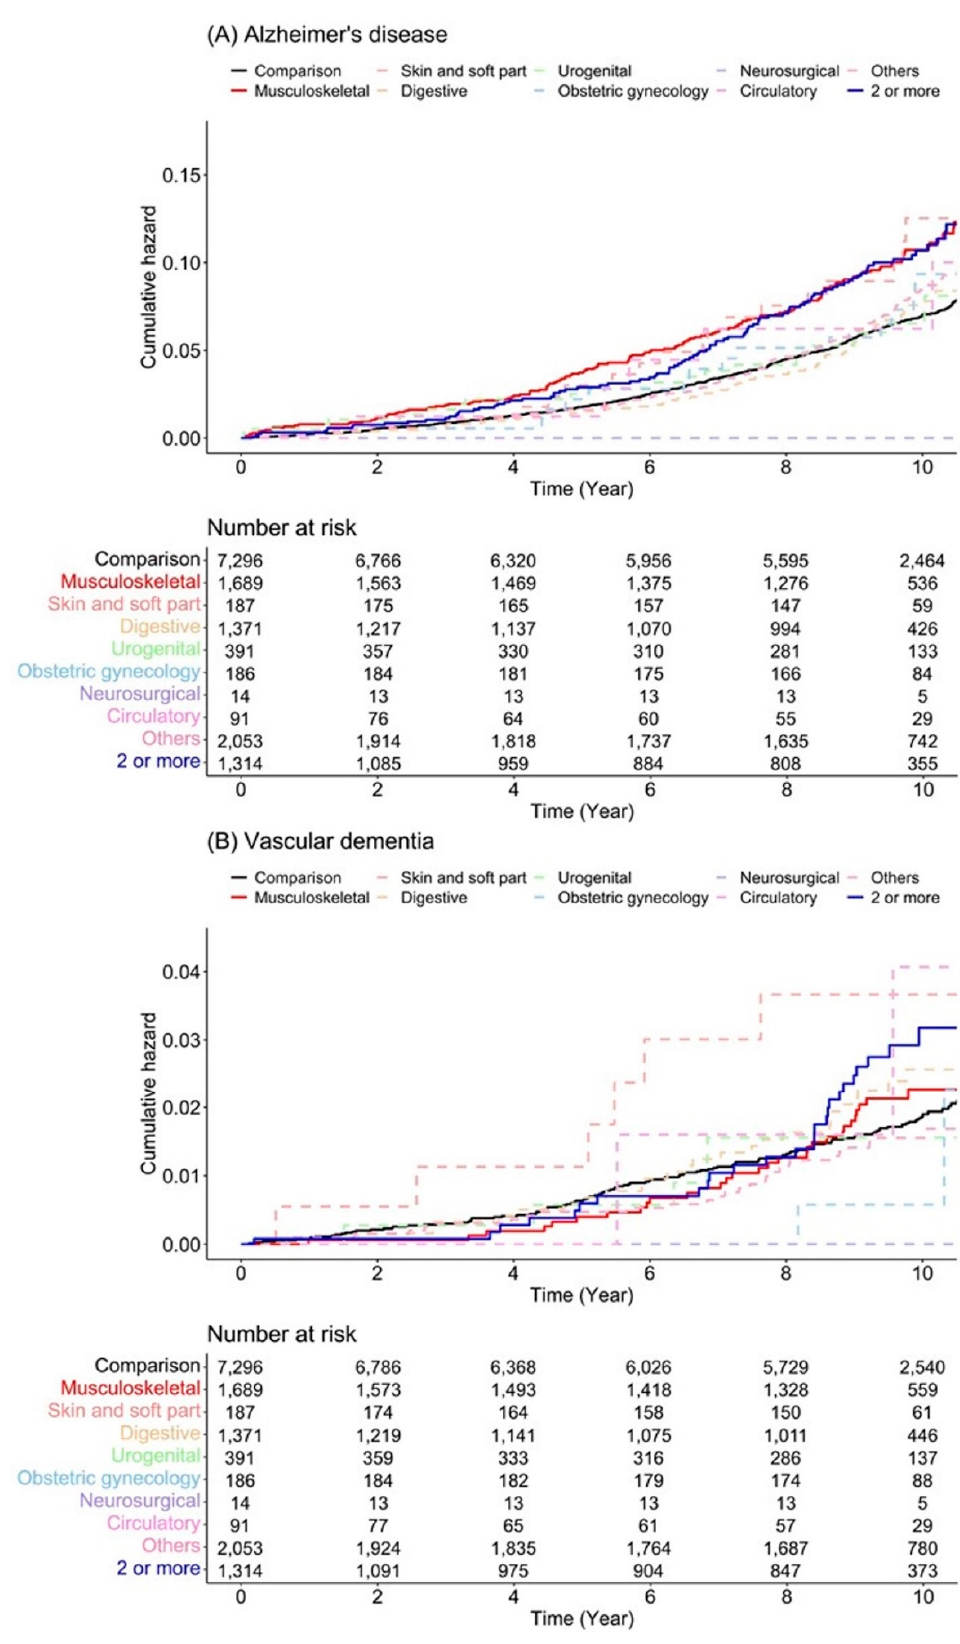
Figure 3. Cumulative hazard plot of specific disease according to surgery type: ( A ) Alzheimer’s disease and ( B ) vascular dementia.